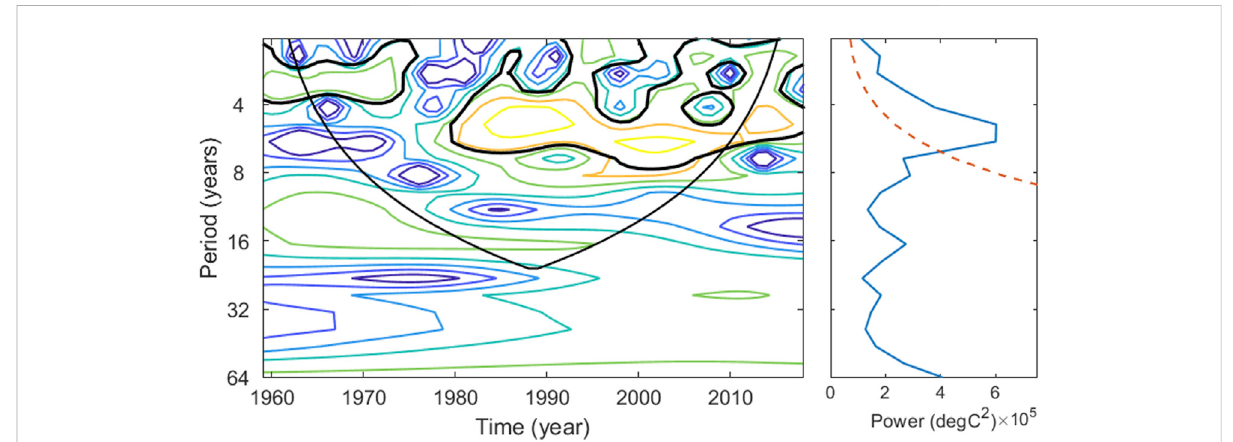
FIGURE 5 Wavelet power spectrum and global wavelet spectrum of TCP over China. (The thick black coil demonstrates that the wavelet transform has passed the standard red noise test at the 95% signi fi cance level. Below the inverted cone, which is impacted by the edge effect, the periodic characteristics are uncertain. The dashed line indicates the 95% con fi dence level. The corresponding cycle is signi fi cant if the peak of the solid line exceeds the dashed line.)